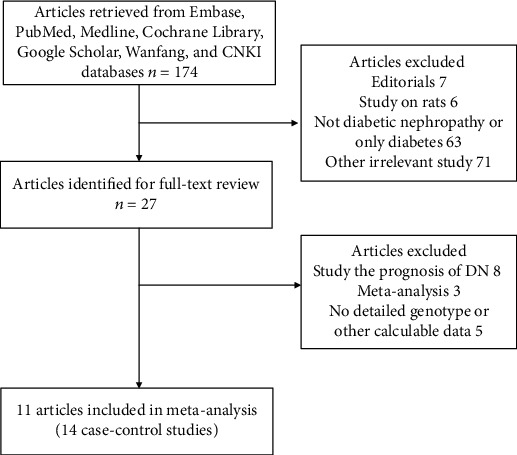
Flowchart illustrating the process of study identification, inclusion, and exclusion.